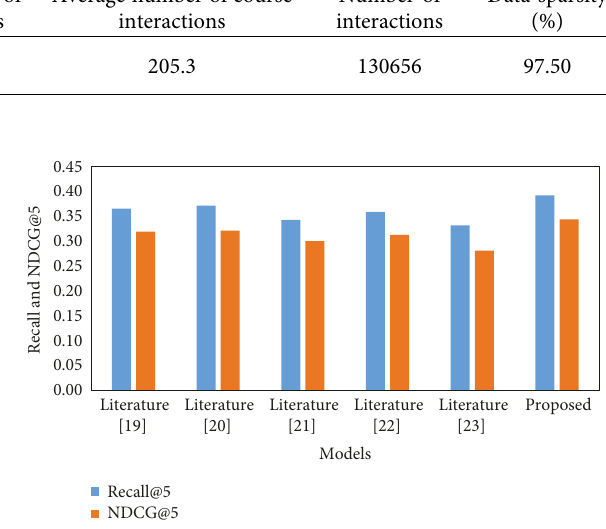
Figure 8: Recall and NDCG experimental